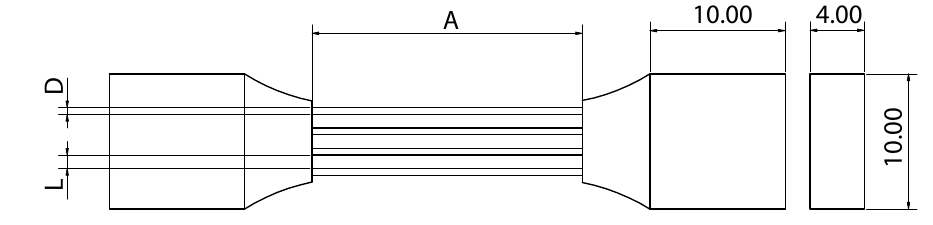
Figure 2. Sketch of the sample